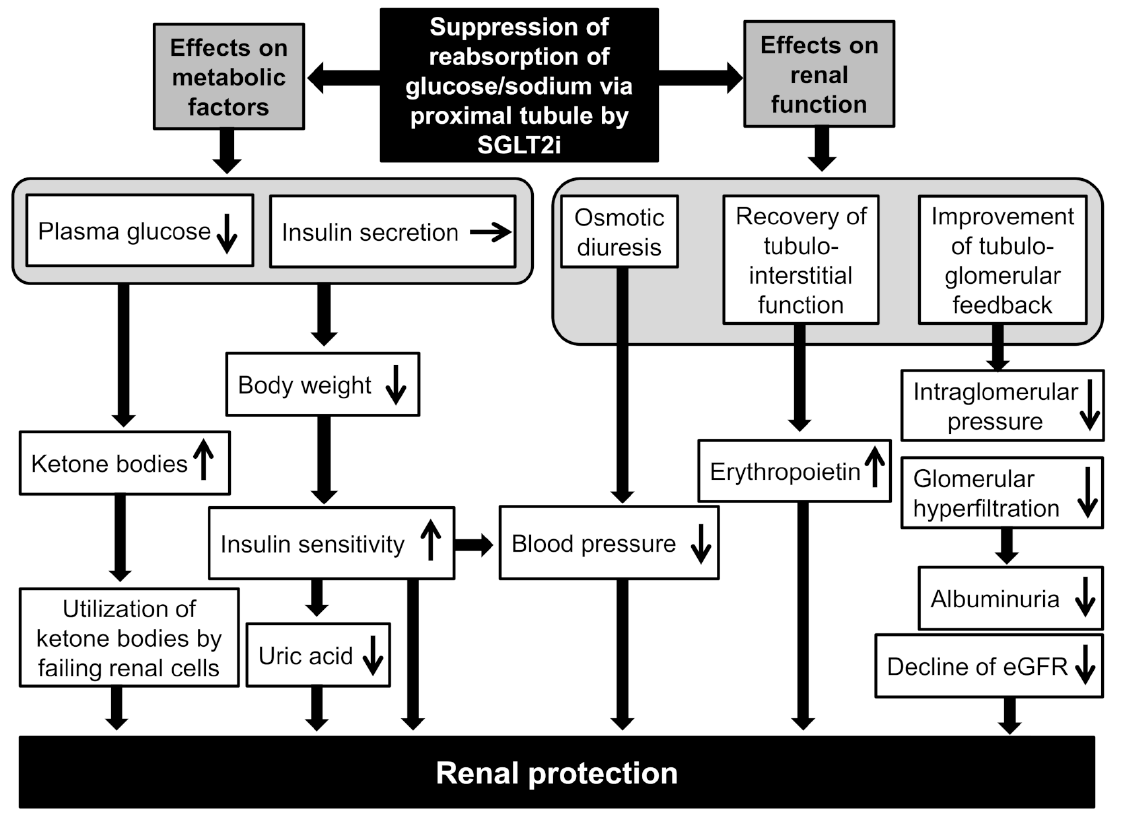
Figure 2. Possible renal protective mechanisms of SGLT2 inhibitors. The up and down arrows in white boxes indicate an increase and a decrease,